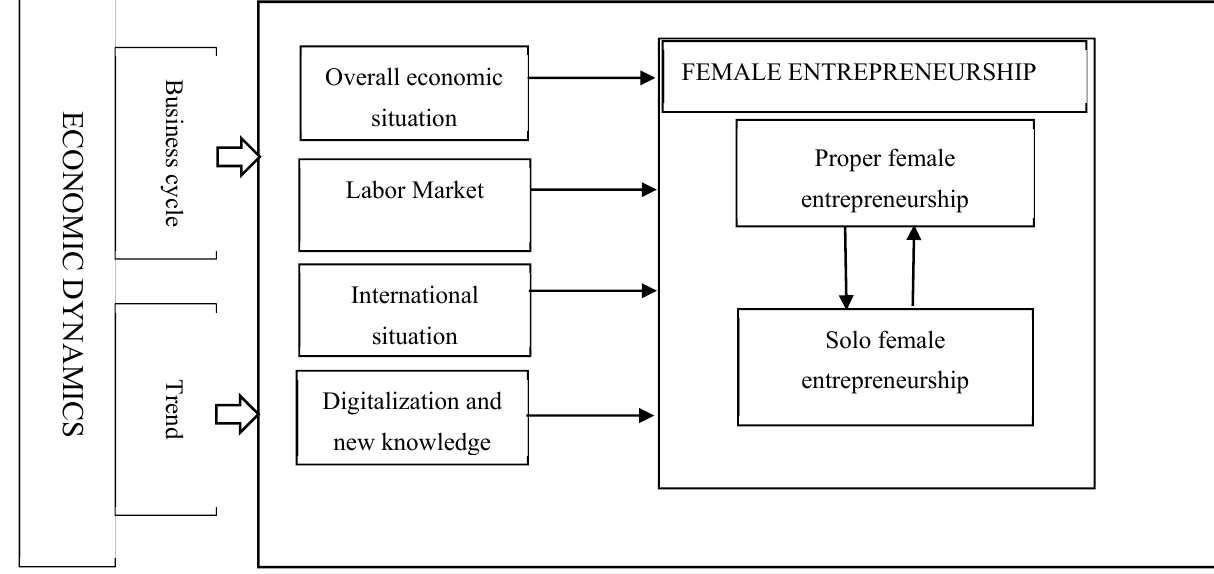
Figure 1. Conceptual framework.